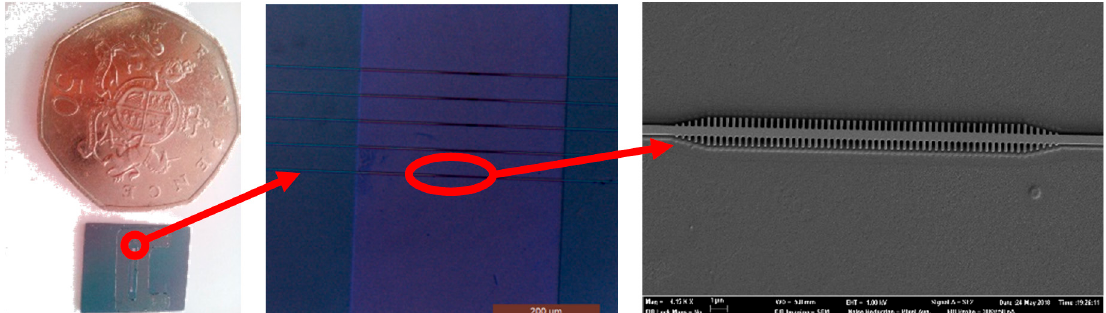
Figure 1. ( Left ) Image of the photonic chip fabricated in Silicon On Insulator (SOI) technology. The circle depicts the position of each photonic bandgap (PBG) sensors groups. ( Center ) Microscope image of a PBG sensors group. The circle depicts an individual PBG sensing structure. ( Right ) Scanning Electron Microscope (SEM) image of a fabricated PBG sensing